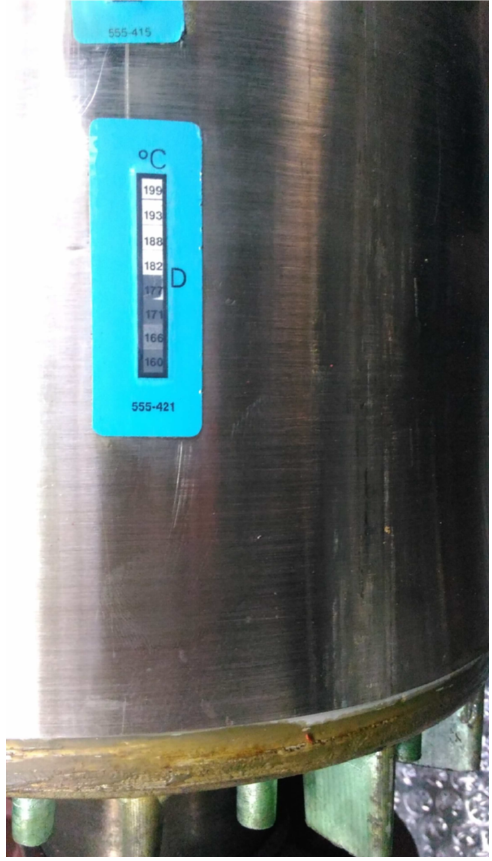
Figure 4. SPM motor rotor thermal label after test at 4